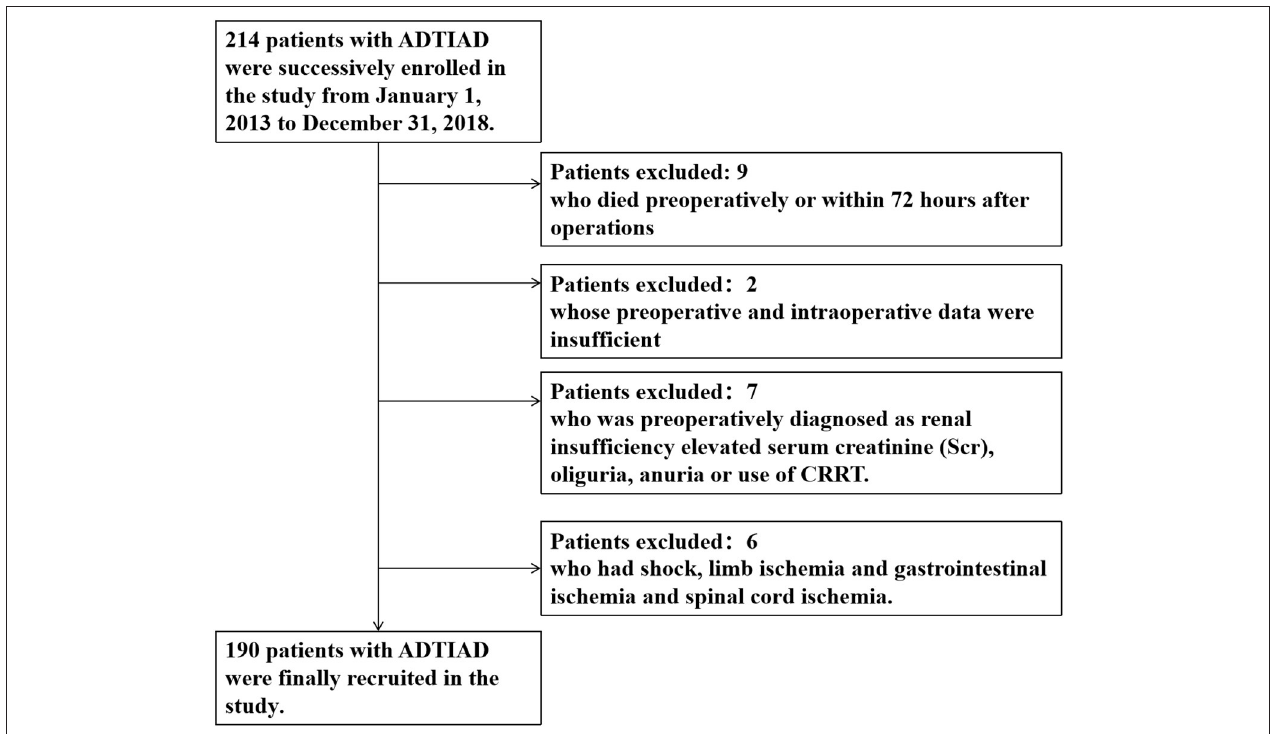
FIGURE 1 | Flow diagram of exclusion and enrollment of study patients. Describes the exclusion and enrollment of study